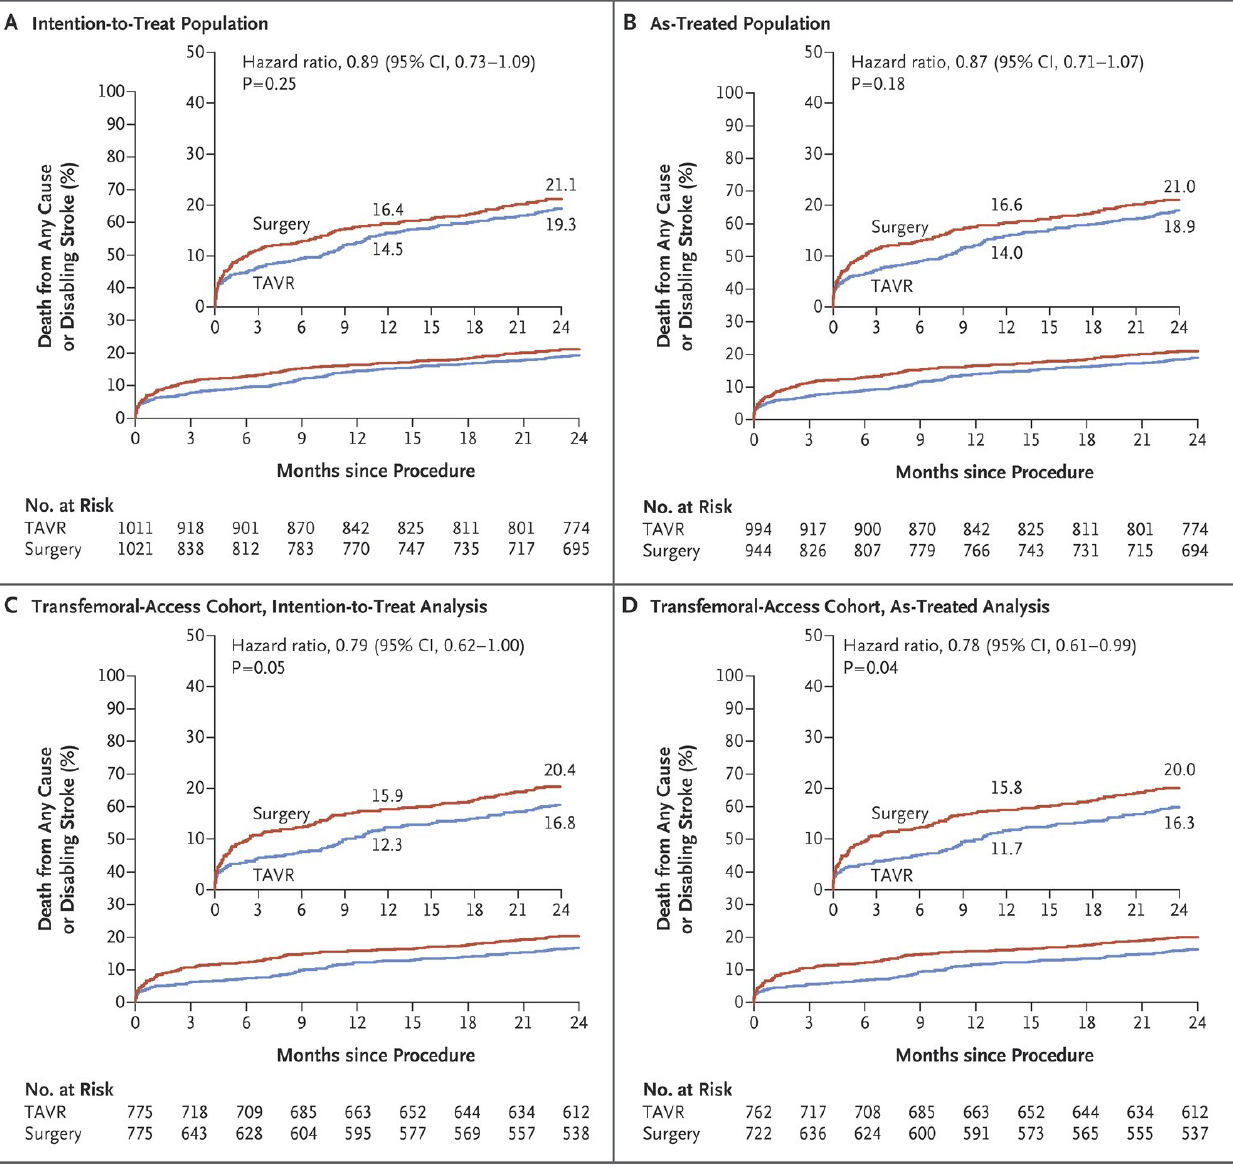
Figure 2. PARTNER 2 Trial Outcomes. ( a ) Time-to-event for death from any cause or disabling stroke in the intention-to-treat population, ( b ) in the as-treated population, ( c ) in the transfemoral-access group in the intention to treat, ( d ) and in the as-treated analysis. From Leon et al. , 2016 8 . Reprinted with permission from Massachusetts Medical